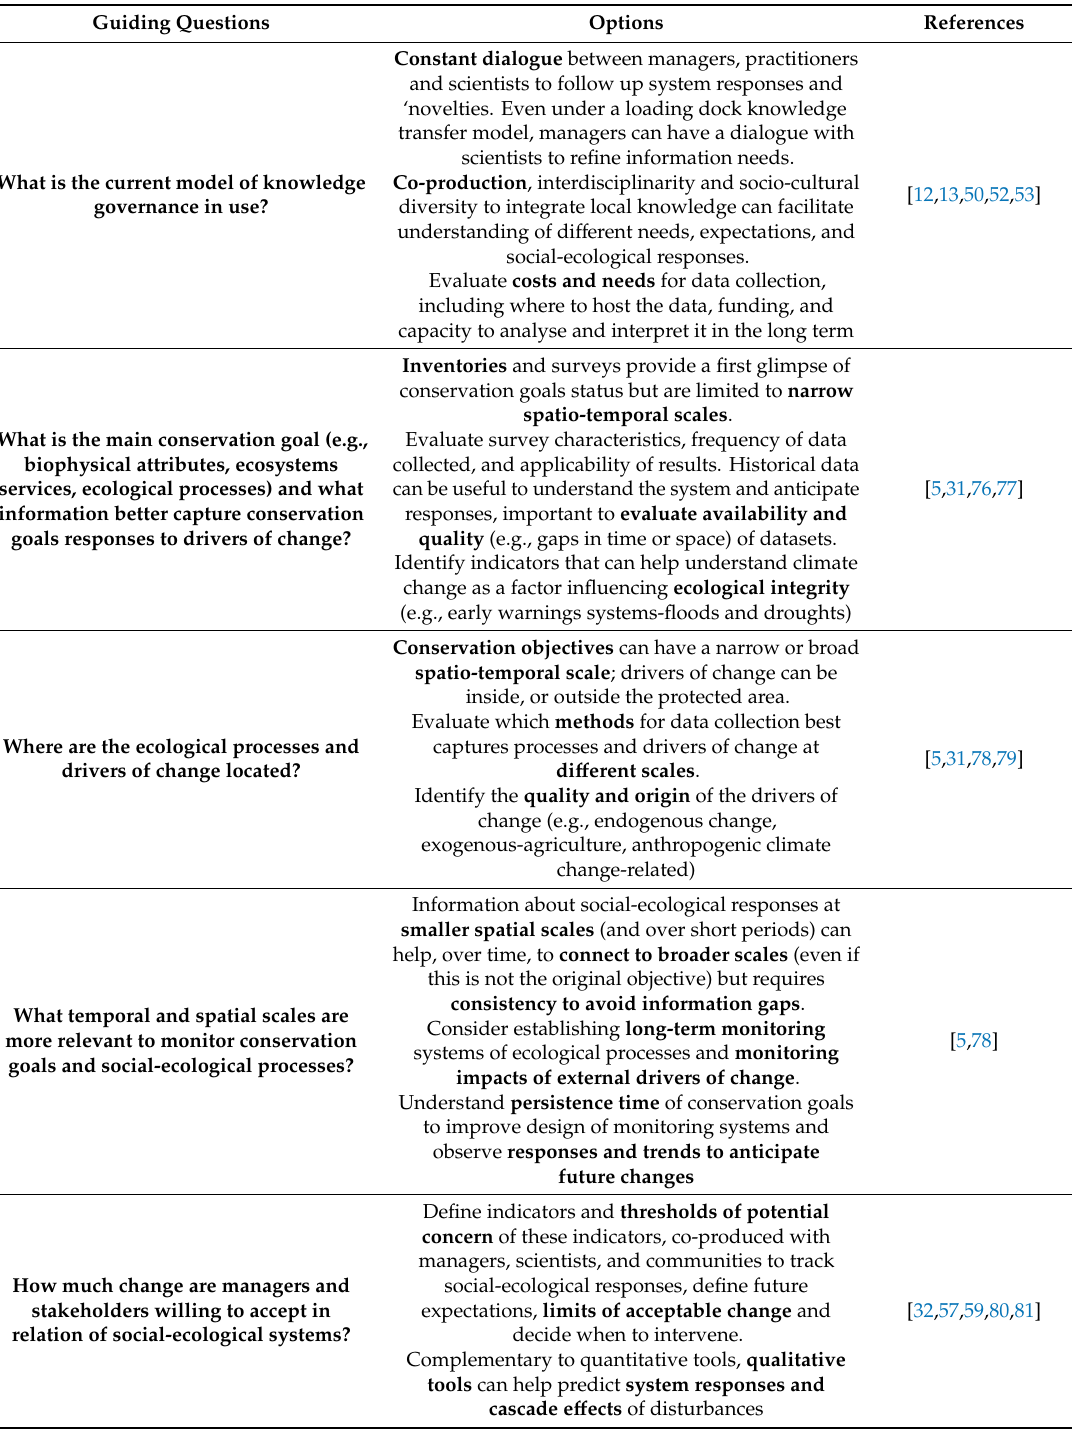
Table A1. Guiding questions for protected area managers to facilitate the reflexivity process in multidimensional knowledge-based processes, and options to consider for the day-to-day practice level. Words highlighted in bold represent some key ideas and issues to